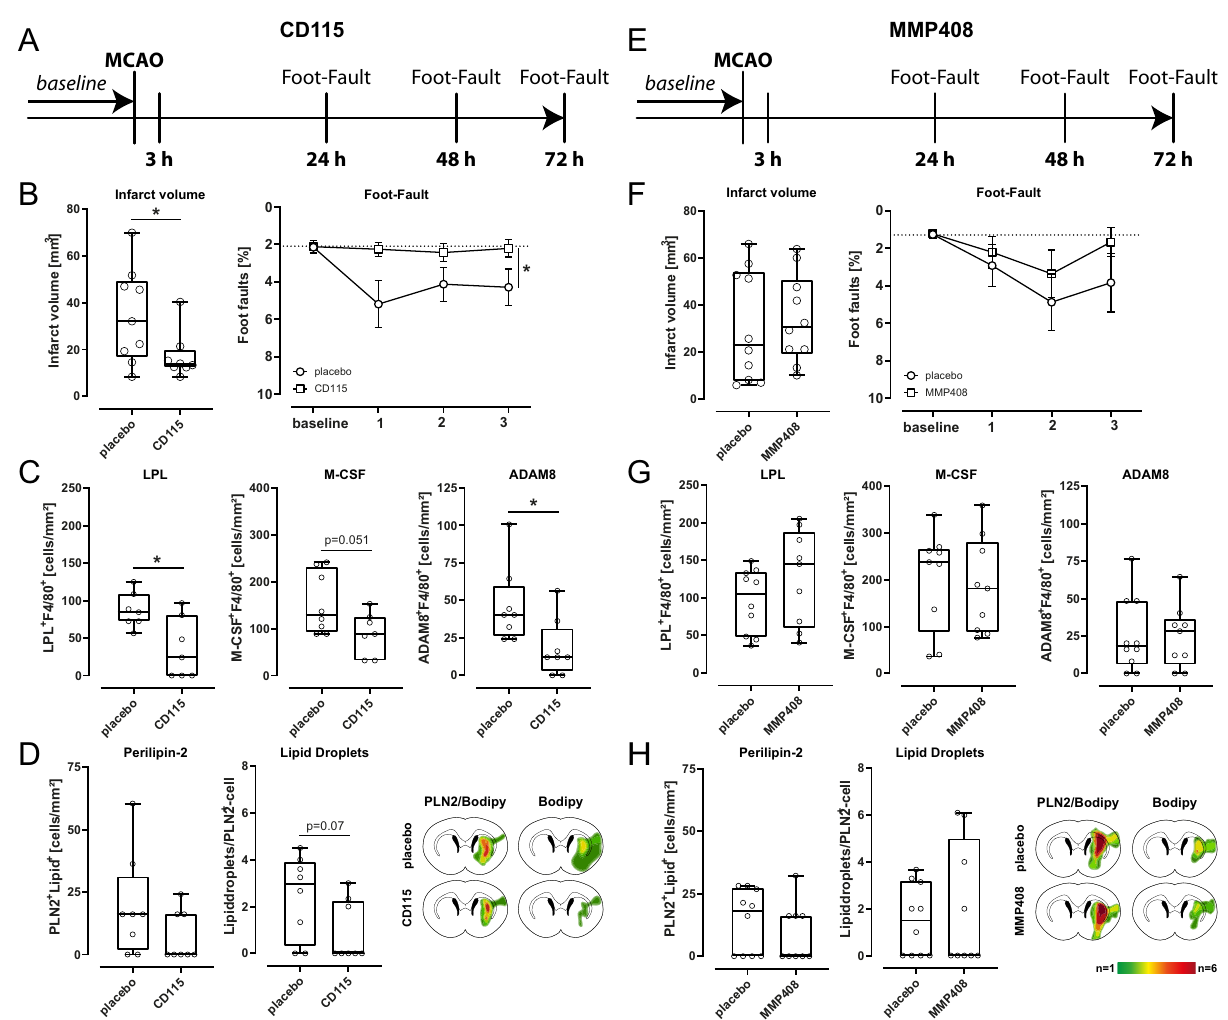
Fig. 5 Speci fi c SAMC blocking treatment in fl uences stroke outcome and immune cell response. A, E Schematic illustration of A M-CSF antibody (CD115) and E MMP-12 inhibitor (MMP408) application over time. Middle cerebral artery occlusion (MCAO) (or sham-operated, as controls) was induced in mice for 45 min. Mice were either injected with anti-CSF-1R mAb (CD115, M-CSF antibody) intraperitoneally at doses of 400 μ g/mouse in 100 μ l PBS or perorally administered with MMP408 (MMP-12 inhibitor) at doses of 750 μ g/mouse in 100 μ l PBS 3, 24, and 48 h after induction of MCAO. Functional outcome was assessed with foot fault performances 24, 48, and 72 h after MCAO. Seventy-two hours post-ischemia mice were intracardially perfused and tissue sections were analyzed by immunohistochemistry. B, F Mean infarct volumes were calculated from coronal cryosections (15 – 20) of mice treated with M-CSF antibody or MMP-12 inhibitor in comparison to vehicle-treated animals collected at 300 µ m intervals and stained with toluidine blue using ImageJ software at 72 h after MCAO (two-sided t -test, * p < 0.05, n = 8 per group; M-CSF antibody: p = 0.0360; MMP-12 inhibitor: p = 0.3131). Median infarct volumes were presented as box plots. The lines inside the boxes denote the medians. The whiskers of box plots: 10 – 90%. The behavioral performances of the mice in each group were measured with the foot fault test at 24, 48, and 72 h post ischemia ( p < 0.05, two-sided t -test, n = 9 per group). Data are presented as mean values ± SEM. C, G Quanti fi cation of LPL + /F4/80 + , M-CSF + /F4/80 + and ADAM8 + /F4 / 80 + cells at 72 h post stroke induction after blocking therapy with SAMC-speci fi c markers M-CSF and MMP12 in comparison to vehicle-treated animals (* p < 0.05, ** p < 0.01, two-sided t -test, n = 9 per group). M-CSF antibody: LPL + /F4/80 + : p = 0.0134; M-CSF + /F4/80 + : p = 0.051;ADAM8 + /F4/80 + p = 0.0253. Median cell counts were presented as box plots. The lines inside the boxes denote the medians. The whiskers of box plots: 10 – 90%. D, H The density of Perilipin-2 and BODIPY positive cells was quanti fi ed on cryosections at bregma 0 – 1 mm 72 h post-MCAO (* p < 0.05, two-sided t -test, n = 9 per group). Cells were quanti fi ed within the region of interest (ROI: striatum of the ischemic hemisphere, measuring 0.256 mm 2 ) on coronal sections at 20x magni fi cation, and heatmaps were generated from brains post 72 h ( n = 8) (two-sided t -test, * p < 0.05). Median cell counts were presented as box plots. The lines inside the boxes denote the medians. The whiskers of box plots: 10 – 90%. Source data for B , C , D , F , G , and H are provided as a Source Data fi